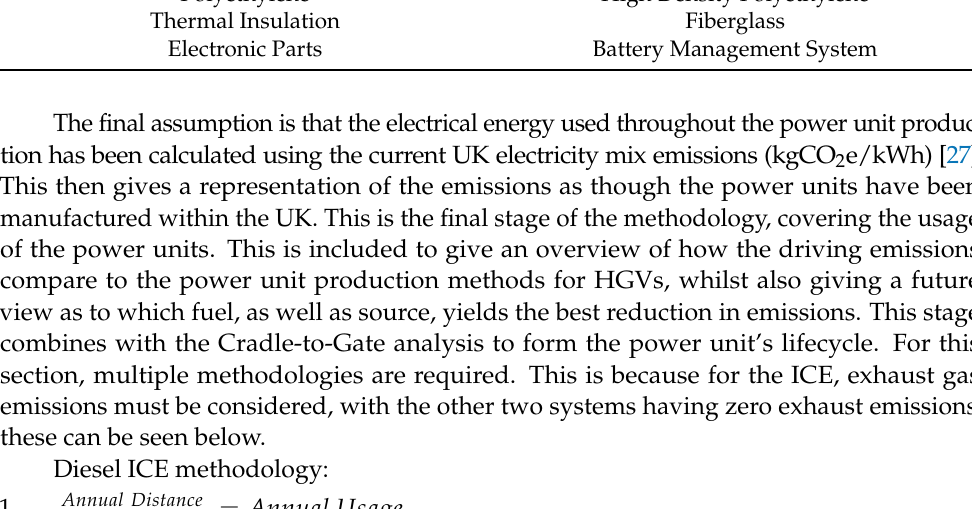
Table 6. Component Assumptions.